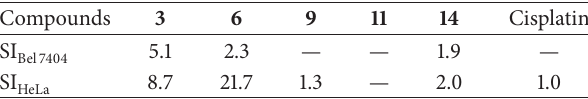
Table 2: SI values of steroidal thiosemicarbazone Pt-complexes. Compounds 3 6 9 11 14 Cisplatin SI 5.1 2.3 — — 1.9 — Bel7404 8.7 21.7 1.3 — 2.0 SI HeLa